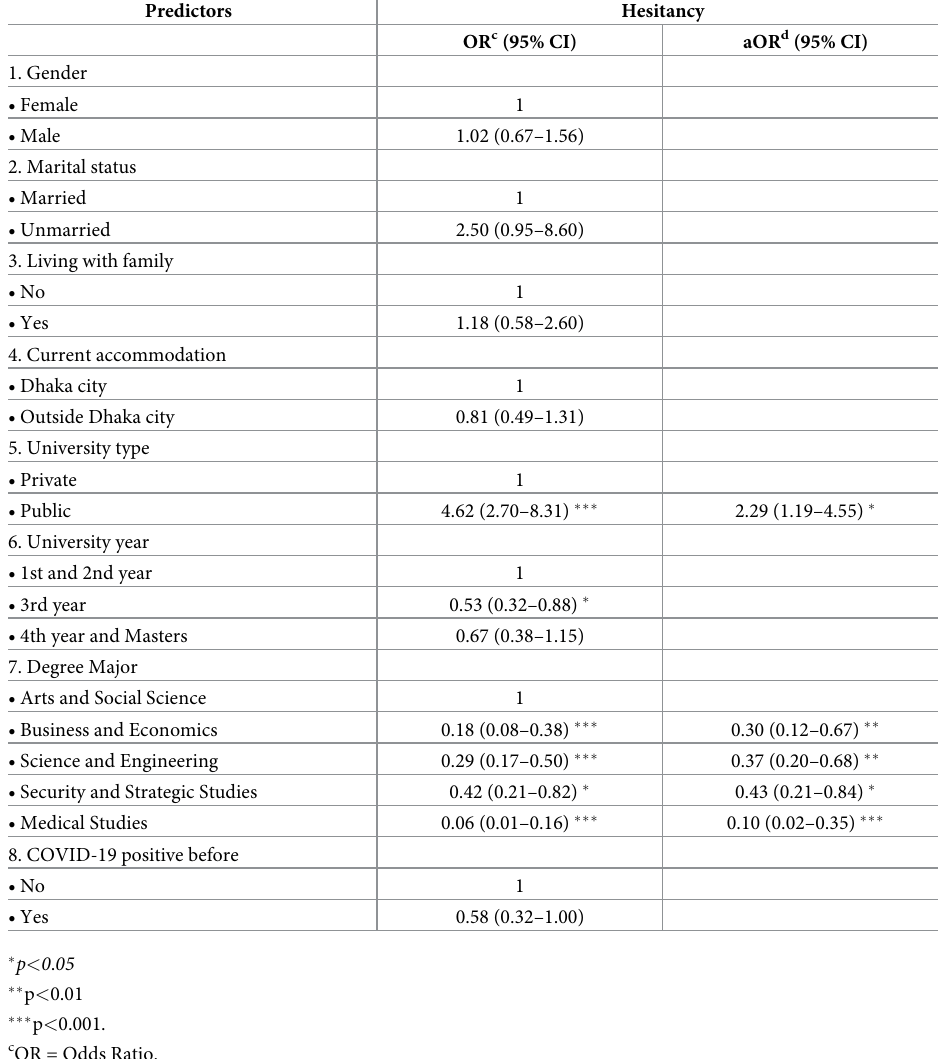
Table 7. Predictors of hesitancy towards COVID-19 vaccine ( n = 449).